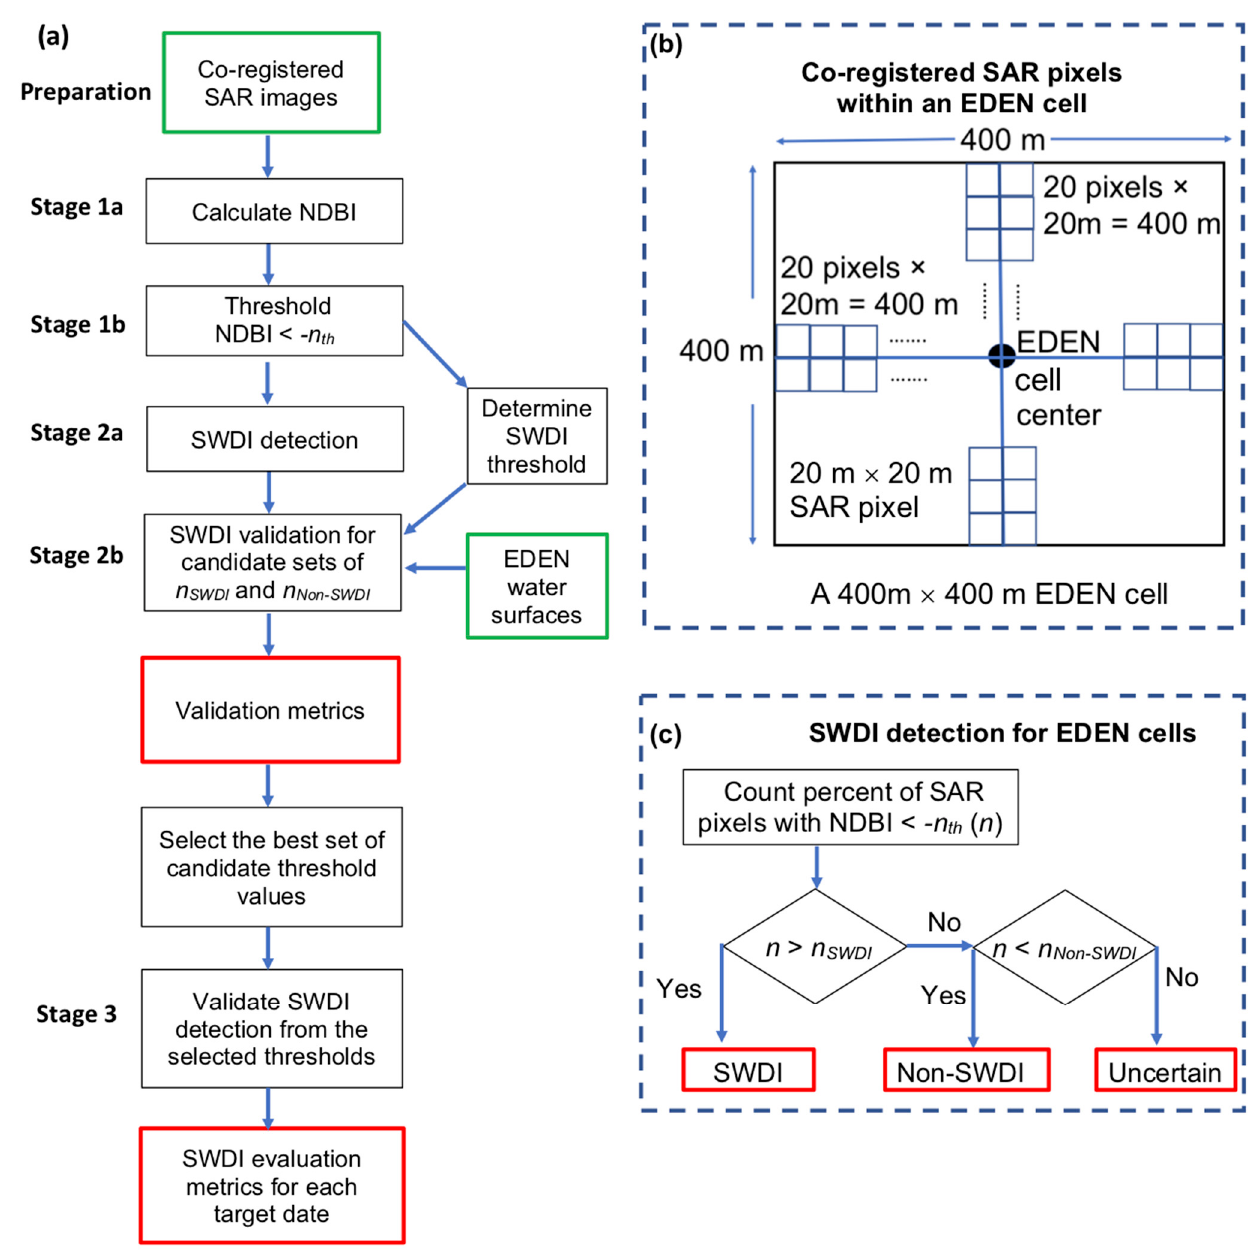
Figure 3. ( a ) Flow chart of the three-stage Significant Water-Depth Increase (SWDI) detection and validation algorithm. Rectangles with a green boundary represent data; rectangles with a black boundary represent analyses; rectangles with a red boundary represent products and results. ( b ) Illustration of 20 × 20 co-registered SAR pixels within an EDEN cell. ( c ) Decision tree of SWDI detection for EDEN cells based on Normalized Difference Backscatter Index (NDBI) values of SAR pixels. Diamonds denote criteria for n , i.e., the percentage of SAR pixels with NDBI < − n th .